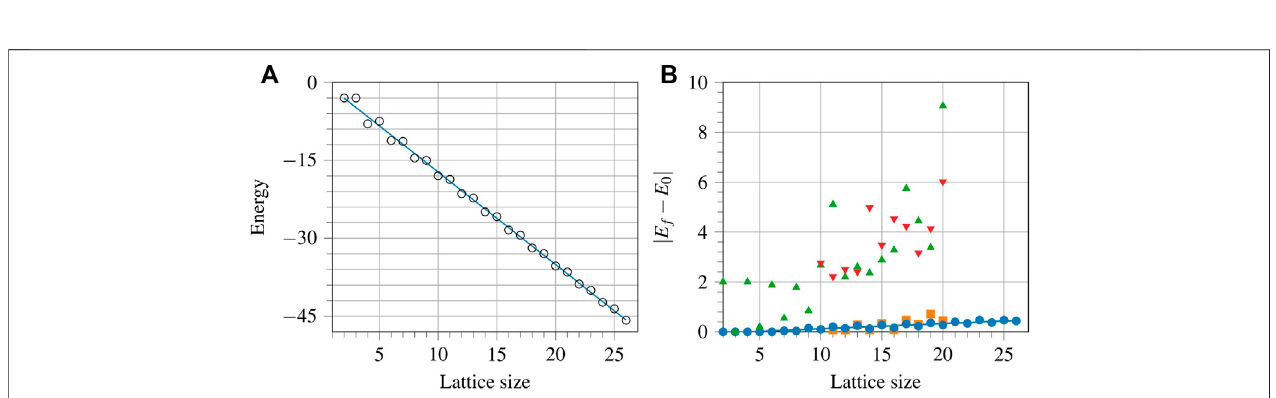
FIGURE 8 | (Colour online) (A) : Least squares fi tting to the variational energies obtained for the one-dimensional isotropic rings of different sizes. The slope of the line, − 1.7783, gives the energy for the in fi nite ring case. (B) : Absolute differences of the variational and ground state energies for different lattice sizes for the isotropic rings using the ansatz from Eq. 9 with p = 1 (green triangles), p = 5 (red inverted triangles), the ansatz from Eq. 7 (orange squares), and the XY-ansatz (blue dots).